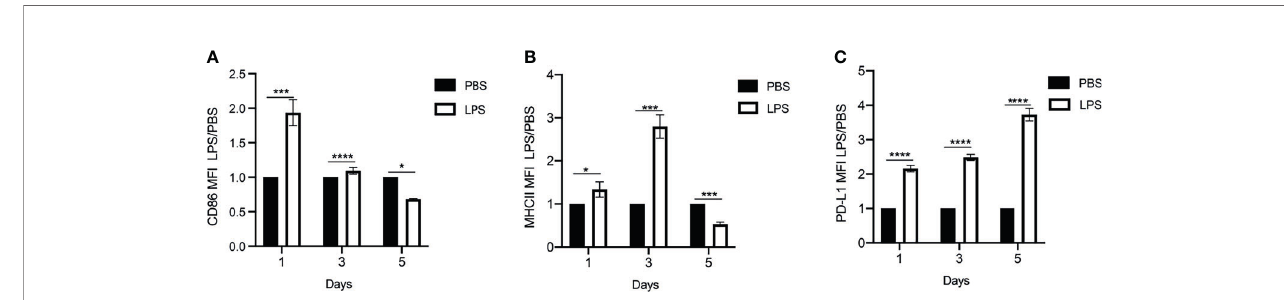
FIGURE 1 | Generation of exhausted monocytes via repetitive LPS challenges. BMDMs were treated with PBS or high dose LPS (100ng/mL) for 5 days. (A – C) The Mean Fluorescent Intensity (MFI) of CD86, MHCII and PD-L1 on day 1, 3 and 5 were monitored using fl ow cytometry. The relative fold changes in MFIs of CD86, MHCII and PD-L1 comparing LPS-treated vs PBS-treated monocytes were determined and plotted in the graphs. Data were representative of three independent experiments, and error bars represent means ± SEM (n=3 for each group). *p < 0.05, ***p < 0.001, ****p < 0.0001, Student t